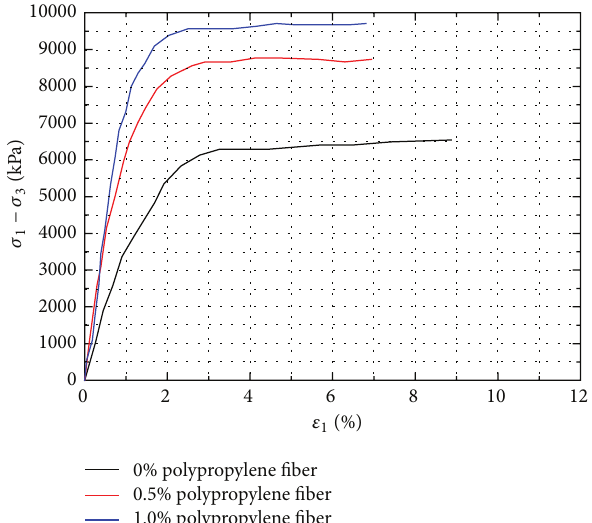
Figure 5: The limit deviatoric stress of different polypropylene fiber content under confining pressure (300